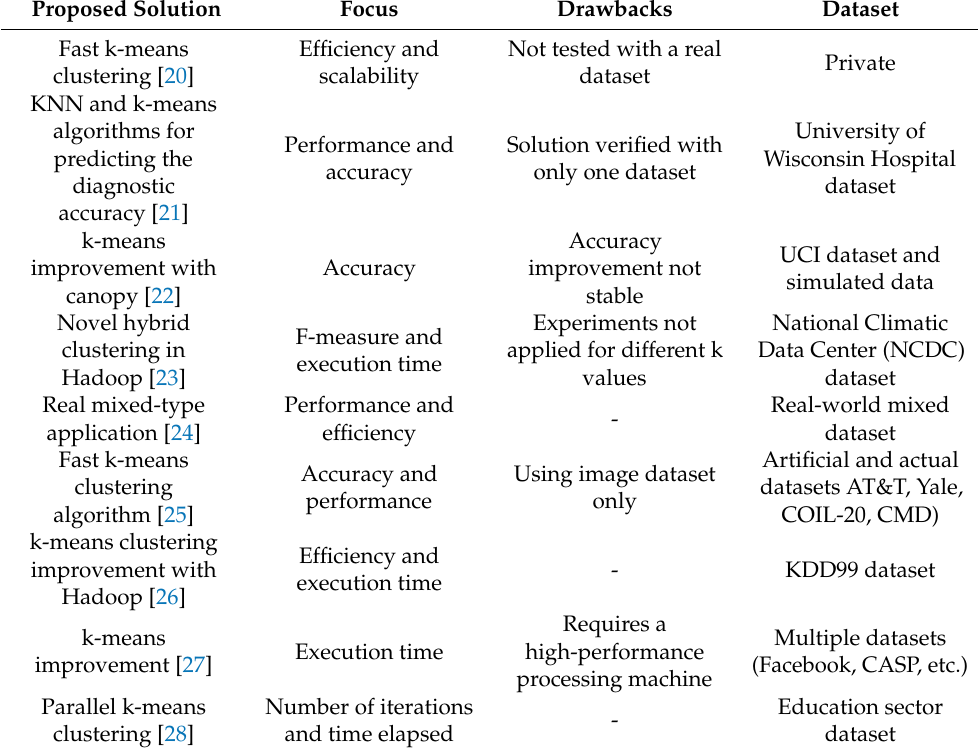
Table 1. Related